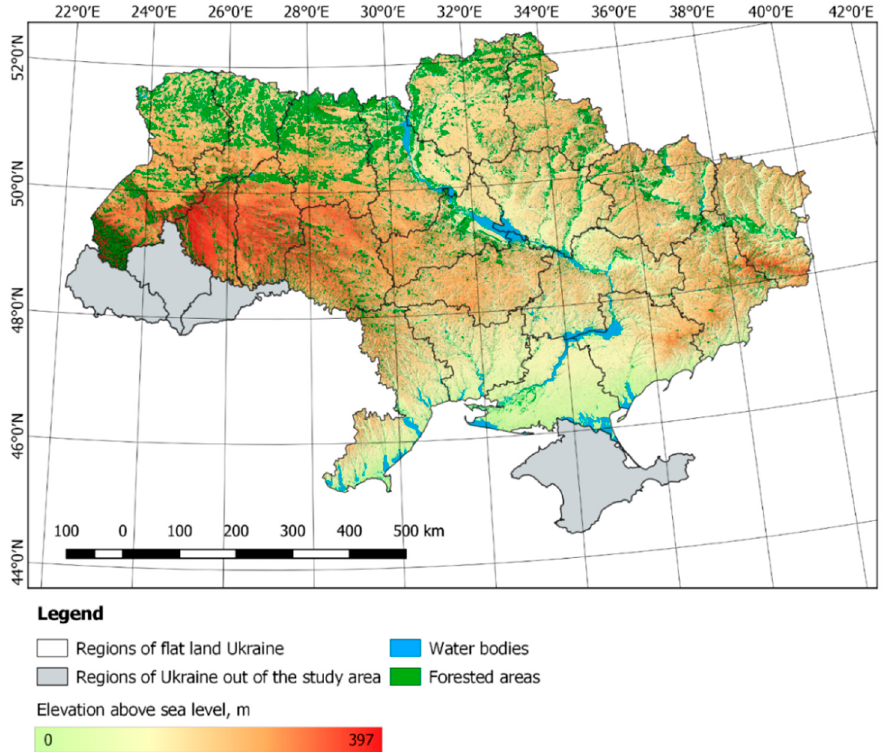
Figure 6. Forest mask of flatland Ukraine derived from classification of combined composited mosaics of Landsat 8 OLI images.